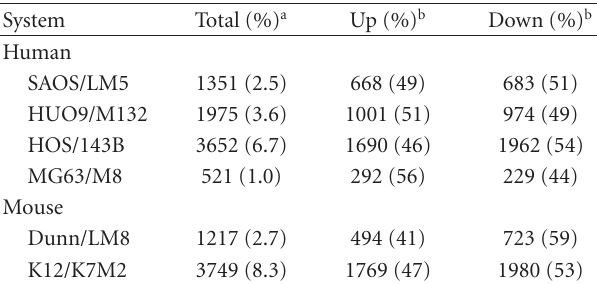
Table 1: Number of regulated ( > 2-fold; fdr < 0.01) probe sets in human and mouse OS cell line